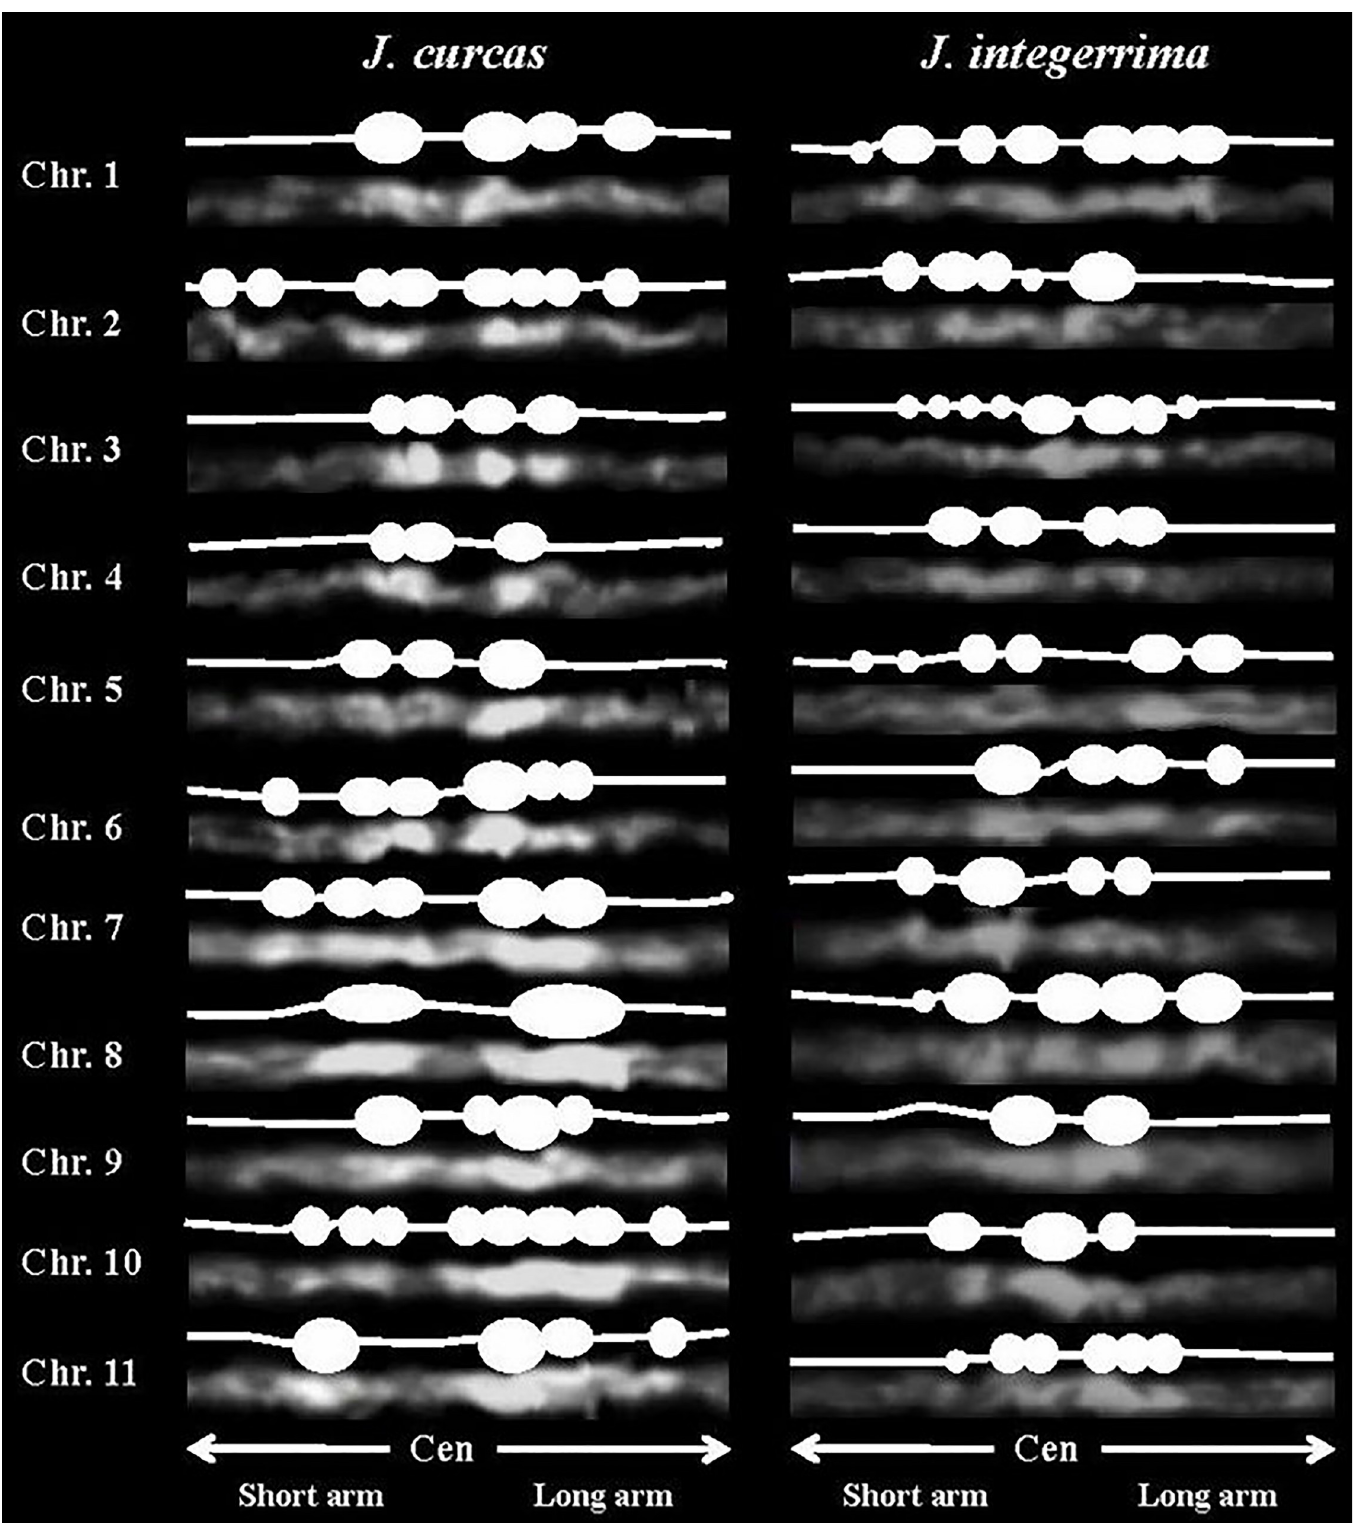
Fig 2. Number and locations of heterochromatin on J . curcas and J . integerrima pachytene chromosomes.